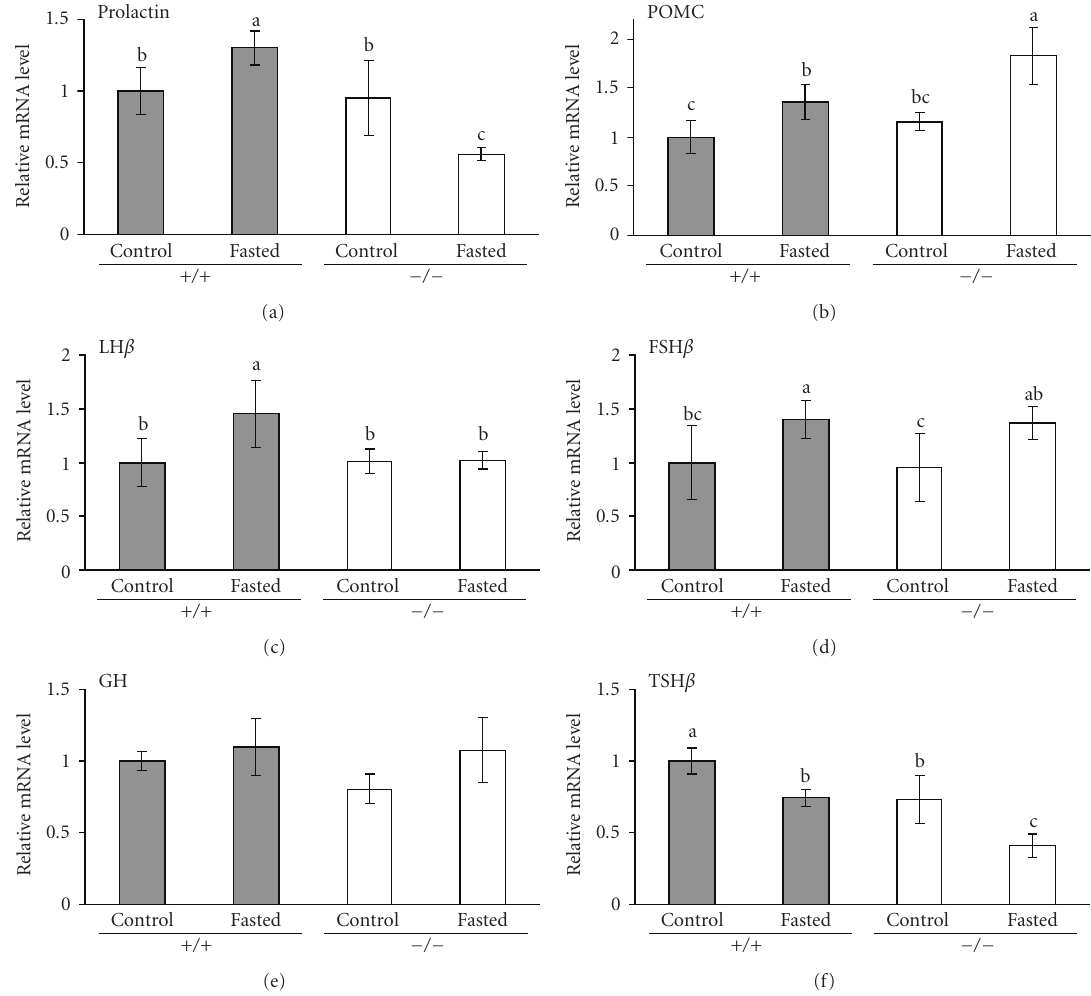
Figure 4: E ff ect of fasting on mRNA concentrations of prolactin, proopiomelanocortin (POMC), luteinizing hormone (LH)- β , follicle- stimulating hormone (FSH)- β , growth hormone (GH), and thyrotropin (TSH)- β in pituitary gland of wild-type (+ / +) and PPAR α knockout mice ( − / − ). Mice of both genotypes were either fasted for 48hours (control group) or fed a standard rodent diet ad libitum for 48hours (control group). Pituitary glands of mice were excised, pooled from two animals, total RNA was extracted, and mRNA abundances were determined by real-time detection RT-PCR analysis using β -actin for normalization. Bars represent means ± SD ( n = 5). Means without a common letter di ff er, P < . 05. Significant e ff ects ( P < . 05) from two-way ANOVA: prolactin: genotype, fasting × genotype; POMC: fasting, genotype; LH β : fasting, fasting × genotype ( P = . 053); FSH β : fasting; TSH β : fasting,